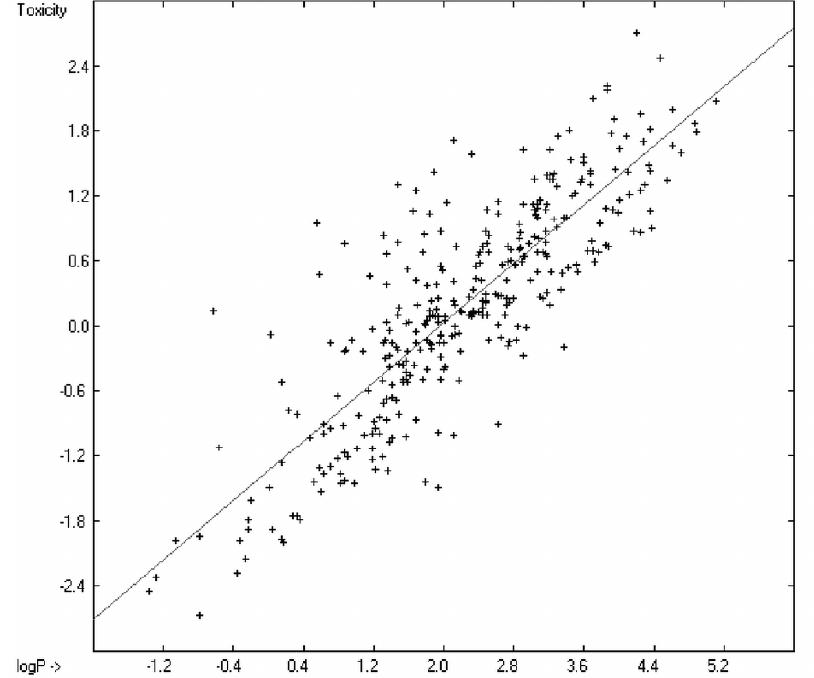
Figure 14. Correlation diagram of logP against toxicity (N = 335, R 2 =